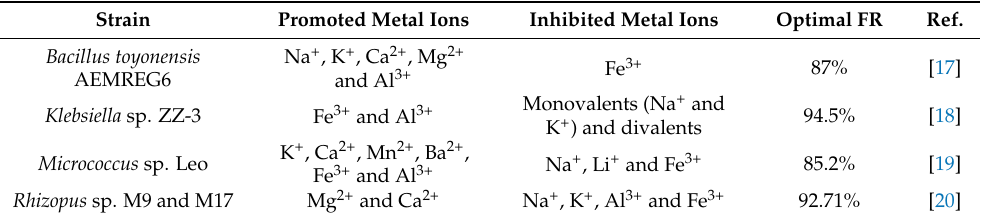
Micrococcus sp. Leo